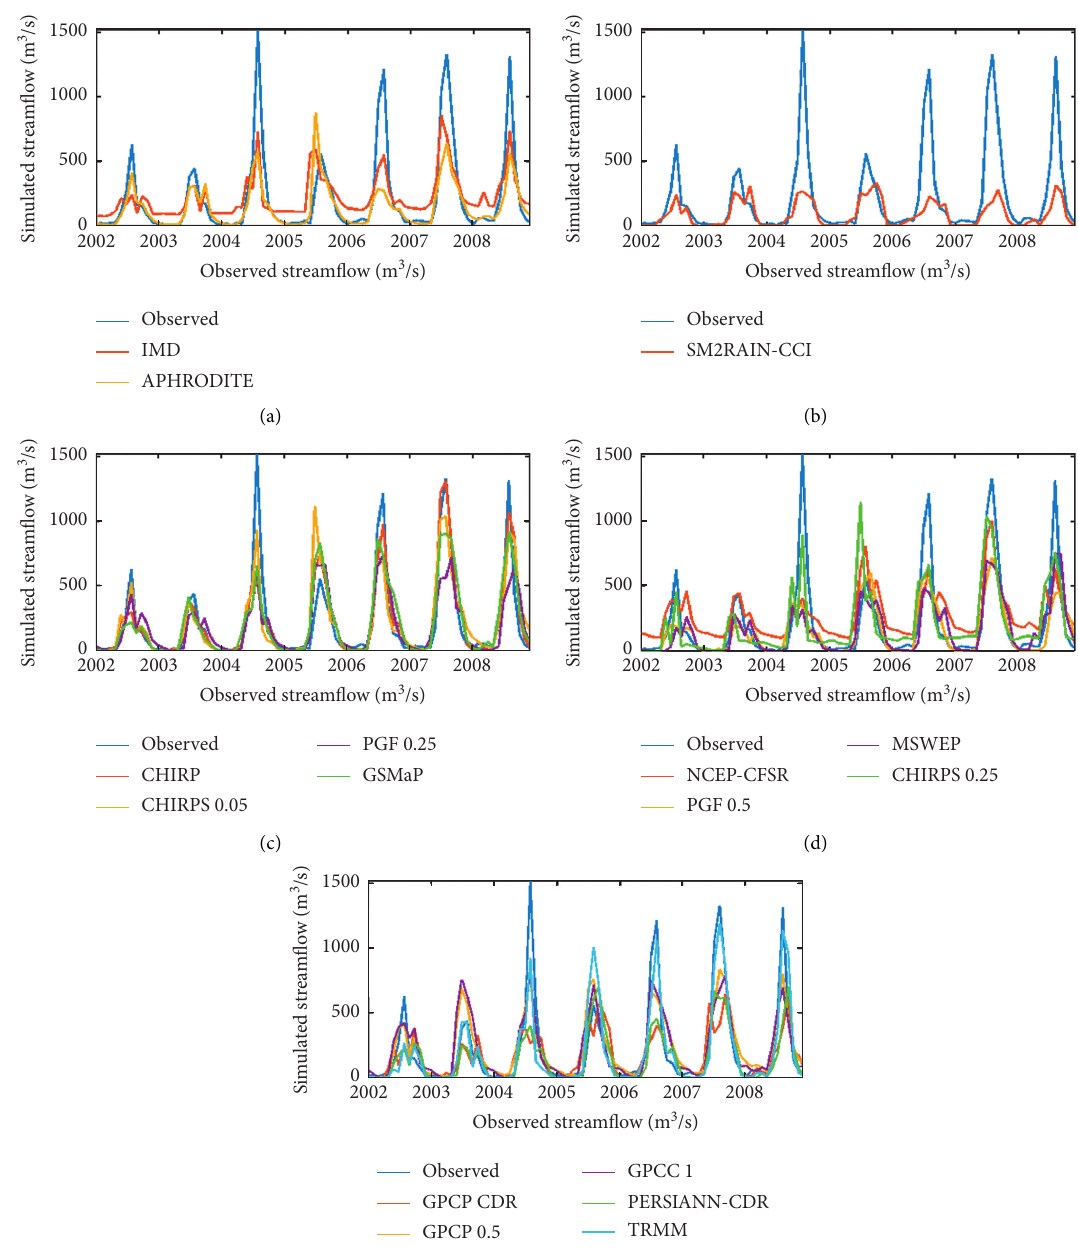
Figure 9: Monthly time series of simulated and observed runoff for observed and (a) gauge-based, (b) satellite-based, (c, d) reanalysis, and (e) gauge-adjusted datasets during the calibration